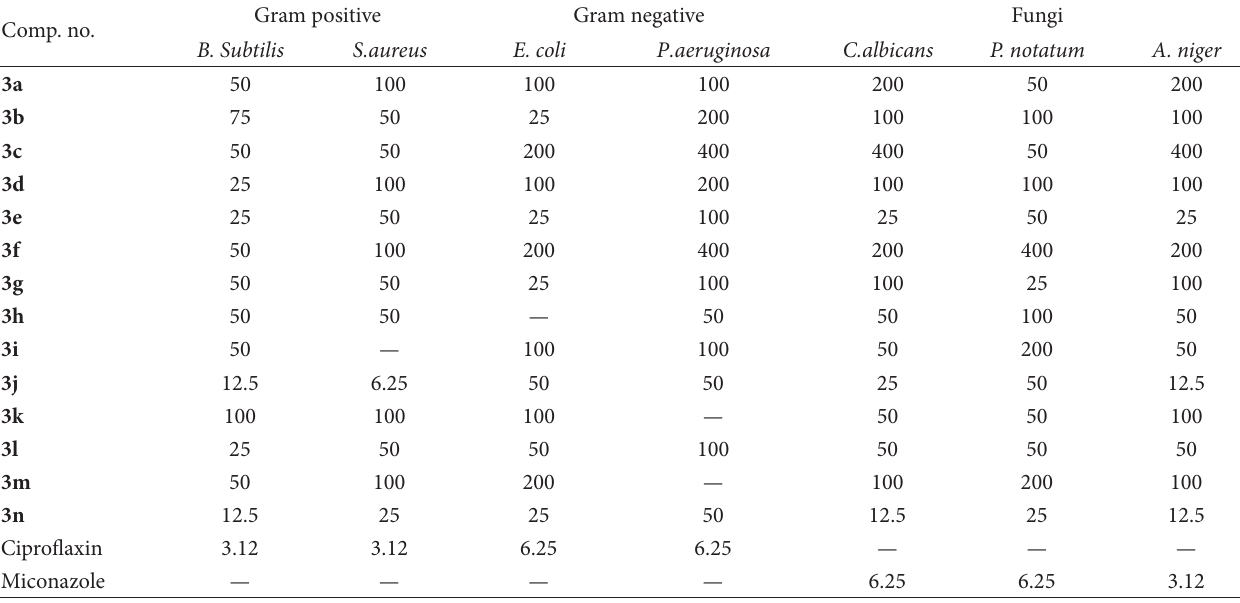
T 2: e in vitro antimicrobial activity of the synthesized